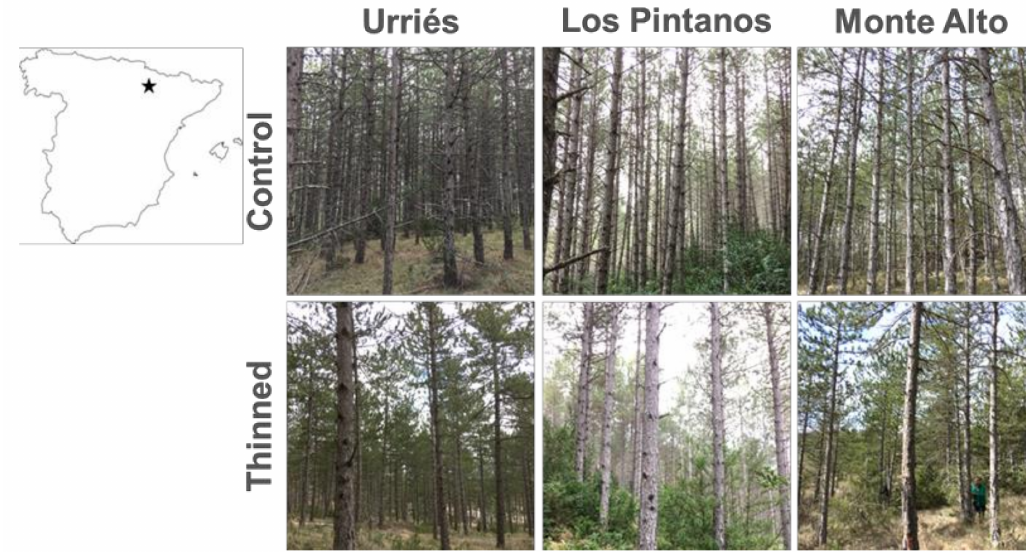
Figure 1. Location of the Cinco Villas study area in Arag ó n, north-eastern Spain, and the control (not-thinned) and thinned plots in the three selected sites. All photographs were taken in the spring of